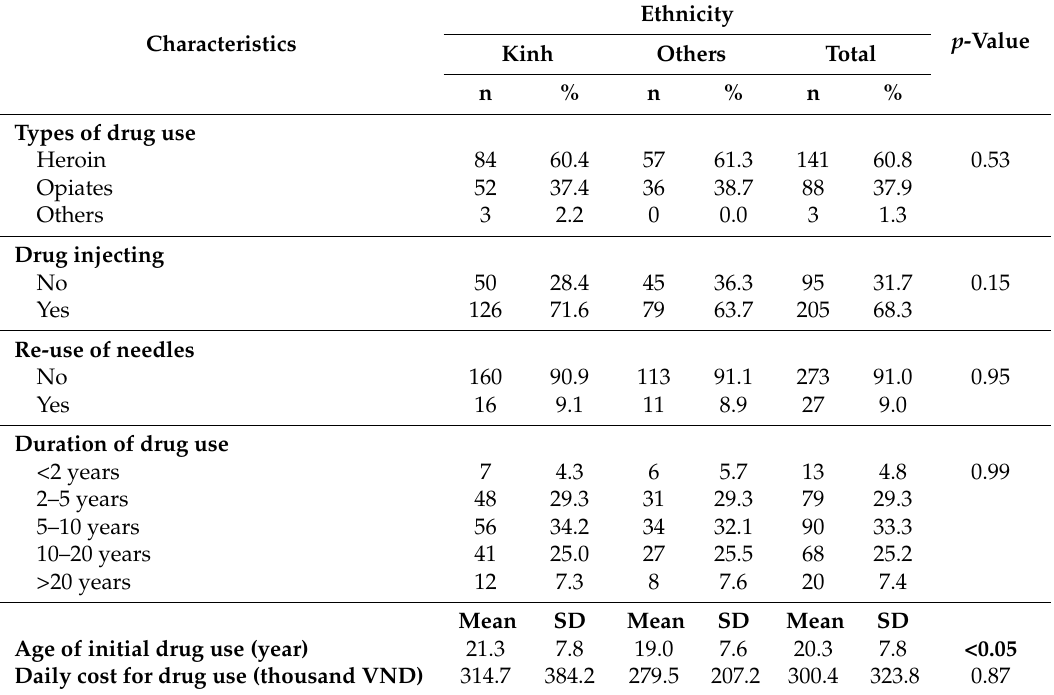
Table 2. A comparison between Kinh and other minority ethnic groups according to drug use behaviors.